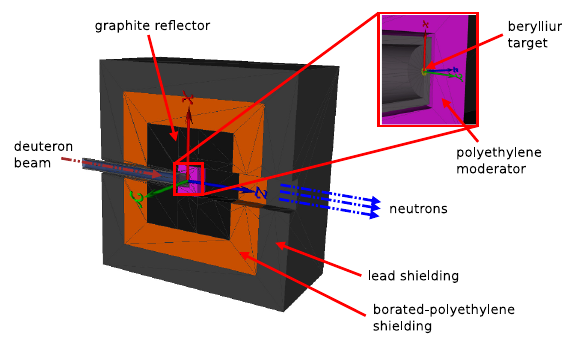
Figure 2: Geometry of the moderator and shielding assembly as simulated in GEANT4